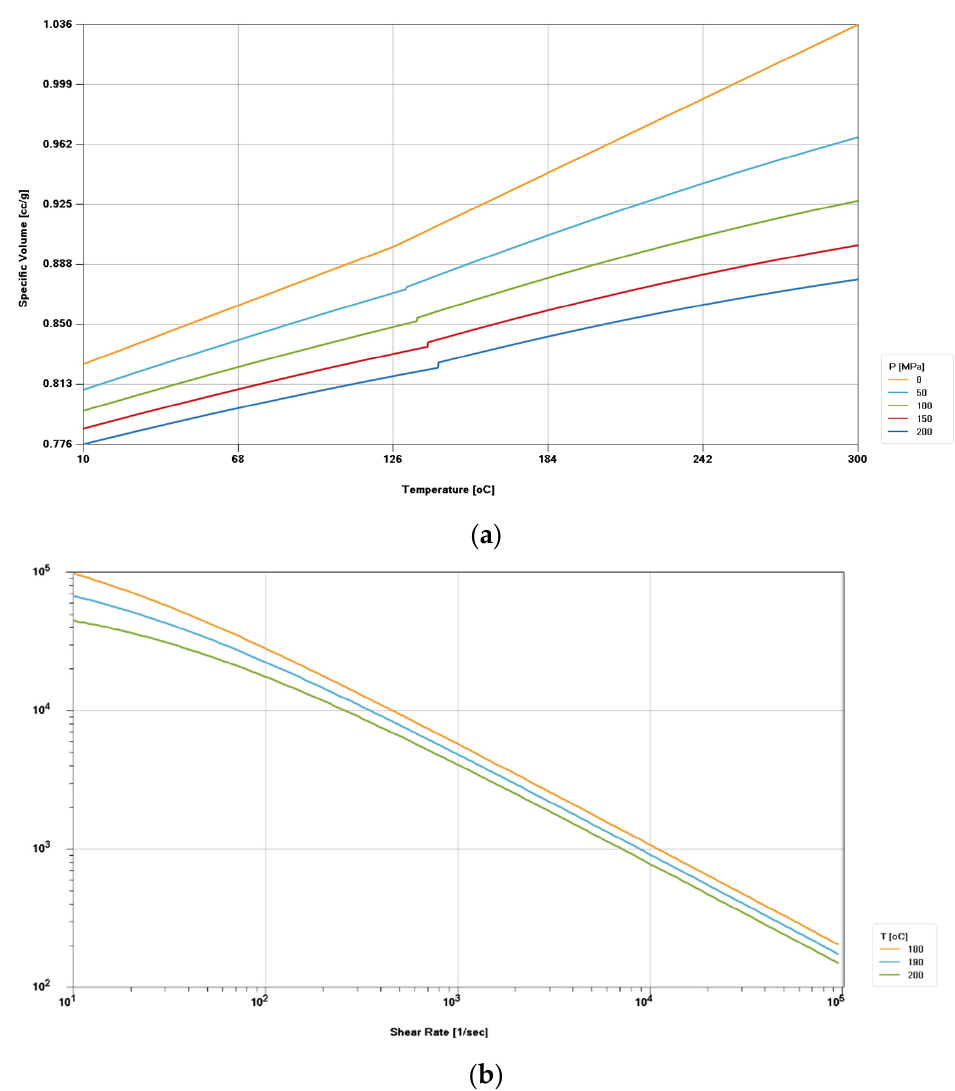
Figure 2. ( a ) pvT data and ( b ) viscosity curves of the Benvic IR705 PVC material.